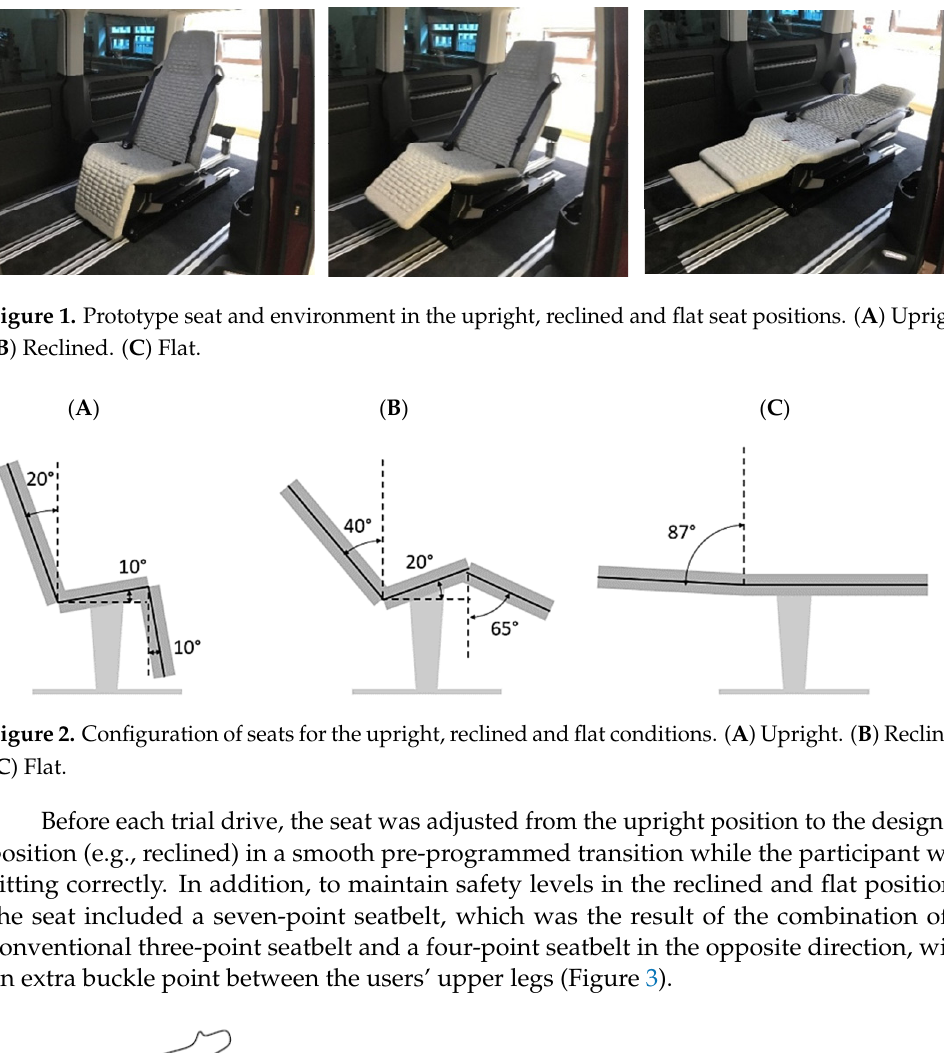
Figure 1. Prototype seat and environment in the upright, reclined and flat seat positions. ( A ) Upright. ( B ) Reclined. ( C ) Flat.